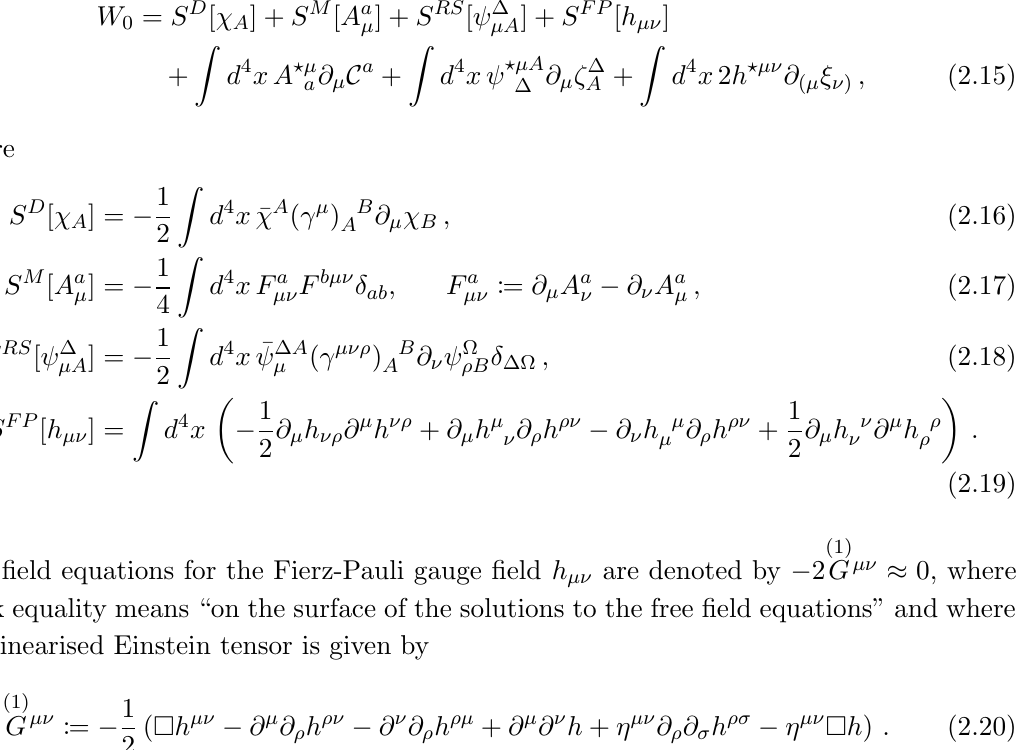
table 1. A central cohomological group for the deformation procedure of the initial